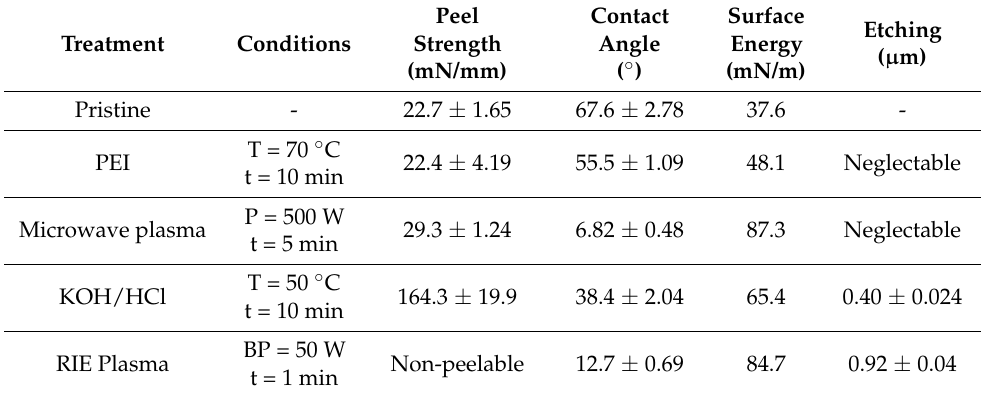
Table 4. Summarizing of characterization results of PI